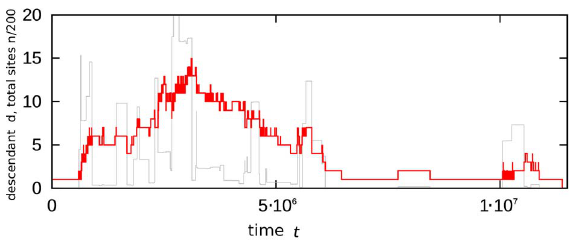
Figure 4. Time evolution of the lineage of a species that starts with one successful species at t ~ 0 . Number of descendant species, d , (red thick line) and total number of occupied sites, n , (scaled down by factor 200, grey thin line) versus time. The parameters are: L ~ 200 , a N ~ 10 { 7 , and E ~ 0 : 02 .